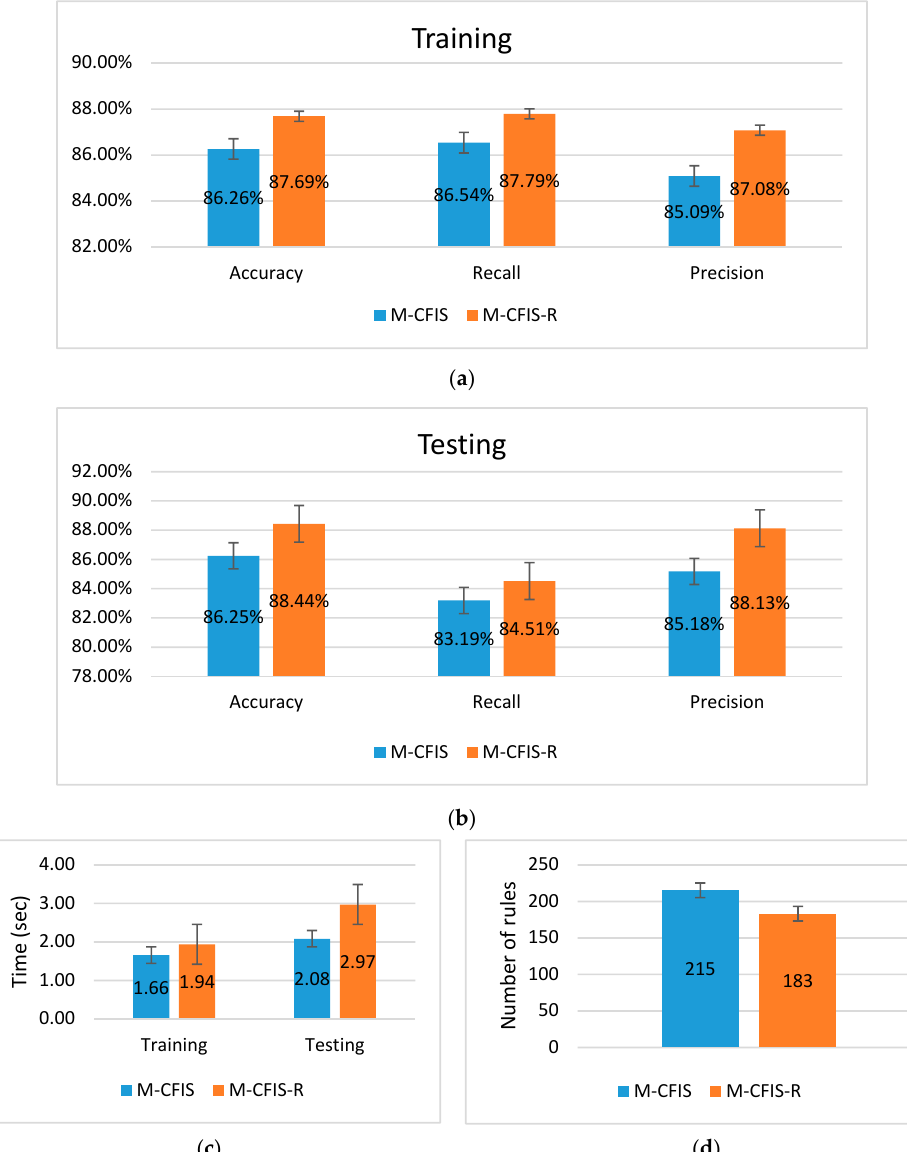
Figure 7. Performance on the Dental dataset: ( a ) Accuracy, Recall, Precision on training set; ( b ) Accuracy, Recall, Precision on testing set; ( c ) Time consumed; ( d ) Number of